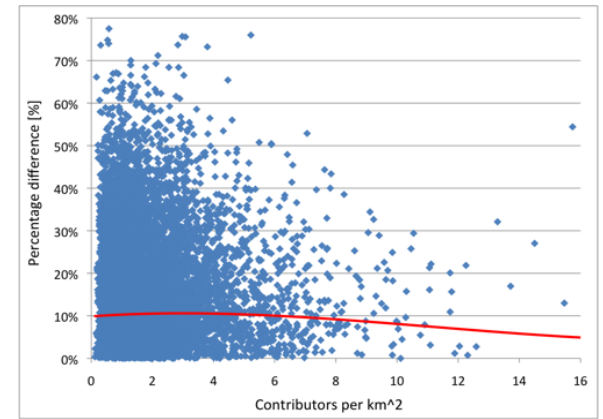
Figure 11. Correlation between Data Completeness and Number of Contributors (June